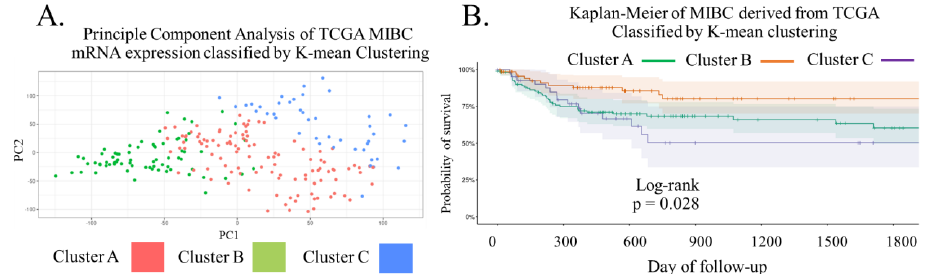
Figure 3 . ( A ) The Kaplan–Meier analysis demonstrated that cluster B displayed the highest proba- bility of survival within 48 months of follow-up while cluster C showed the lowest value. ( B ) RNA- based molecular subtypes are associated with pathologic response to neoadjuvant chemotherapy. ( C ) RNA-based molecular subtypes are associated with pathologic response to adjuvant chemother- apy